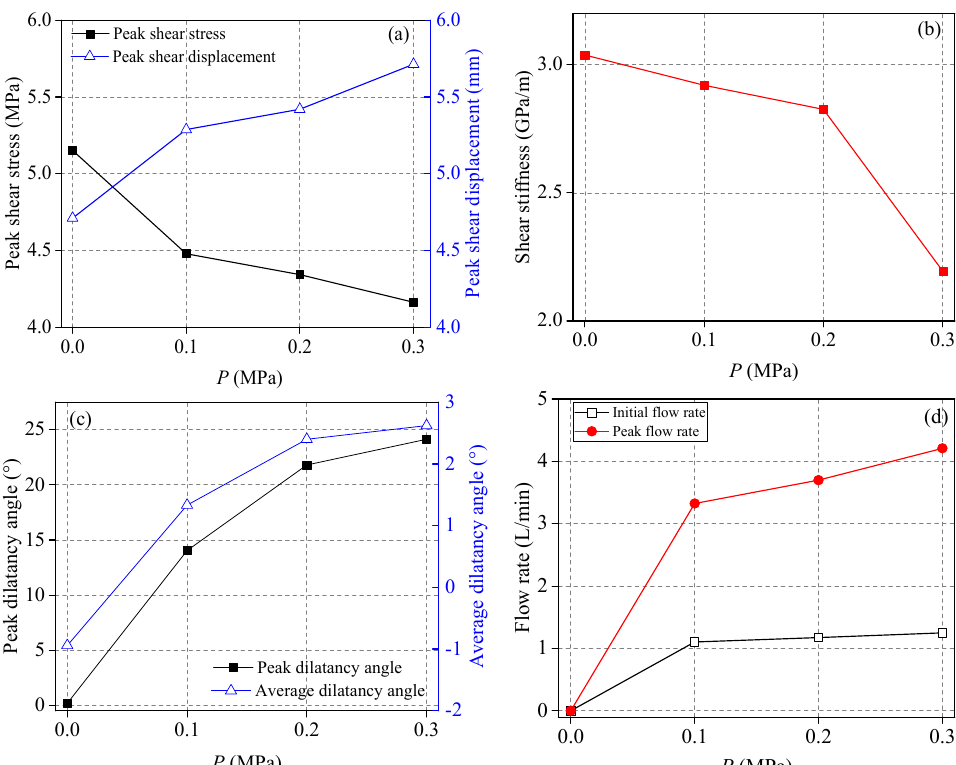
Figure 4. Evolution of ( a ) peak shear stress and peak shear displacement, ( b ) shear stiffness, ( c ) peak dilatancy and average dilatancy angle, ( d ) flow rate.